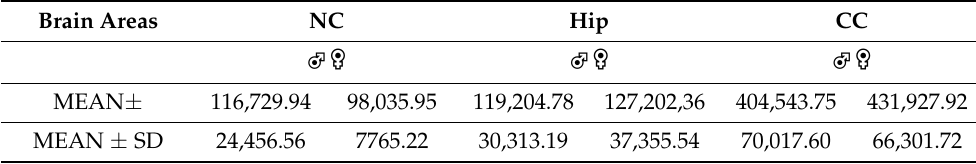
Table 1. The density of OLGs/mm 3 in the selected brain areas of the red kangaroo.